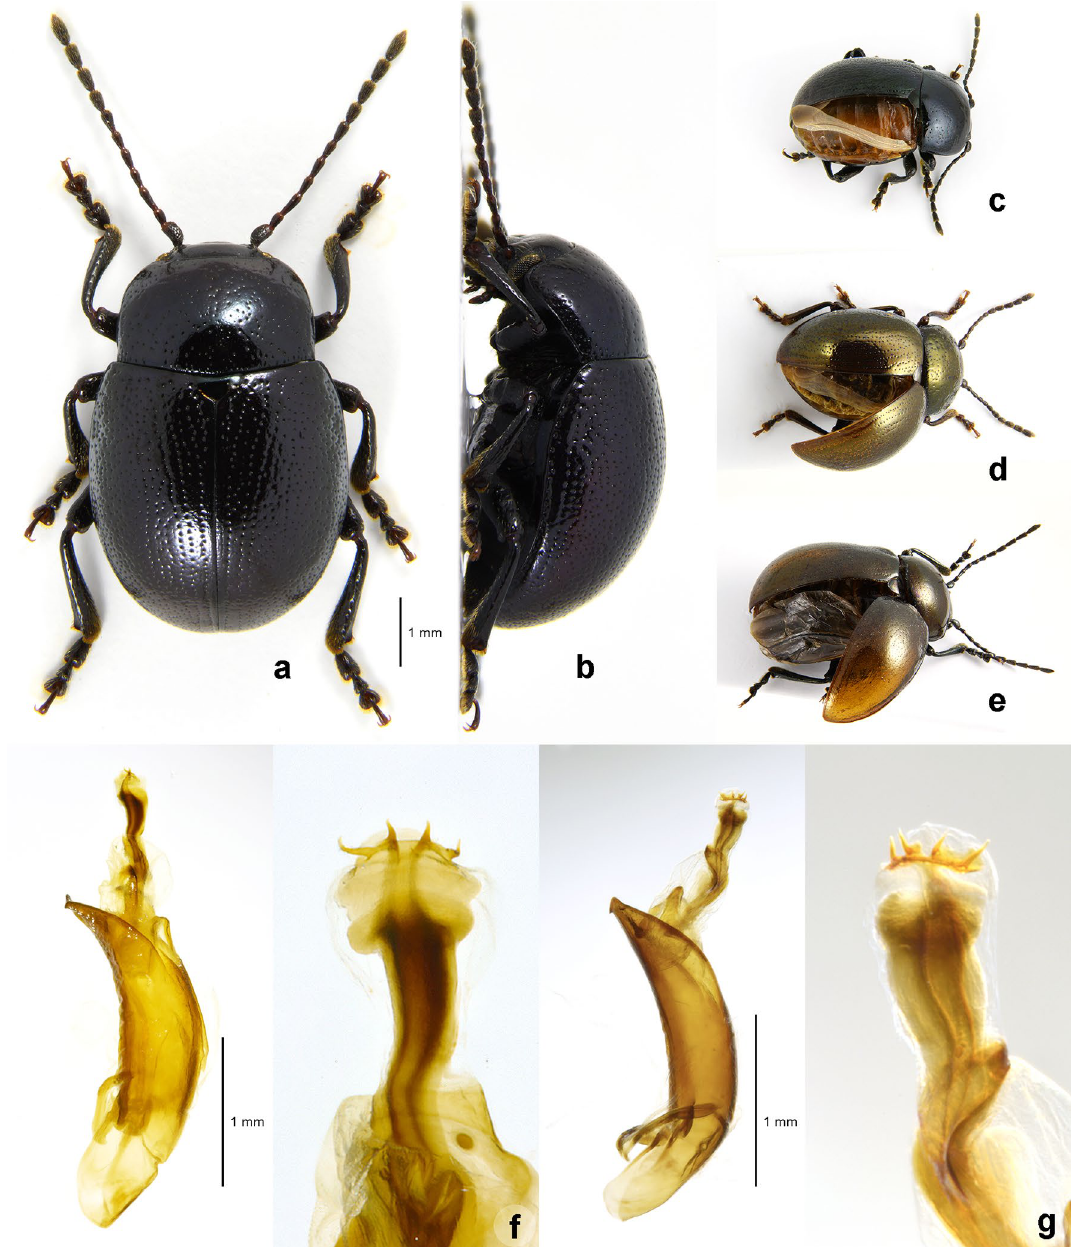
Figure 1. Morphology of Suinzona borowieci sp. nov. and related species: (a,b) Holotype of S. borowieci sp. nov. (a) Dorsal habitus, (b) lateral habitus; (c–e) exposed hind wing, (c) S. borowieci sp. nov., (d) S. cyrtonoides , (e) Potaninia assamensis ; (f–g) aedeagus with everted internal sac (left) and flagellum (right); (f) S. borowieci sp. nov., (g) S . cyrtonoides